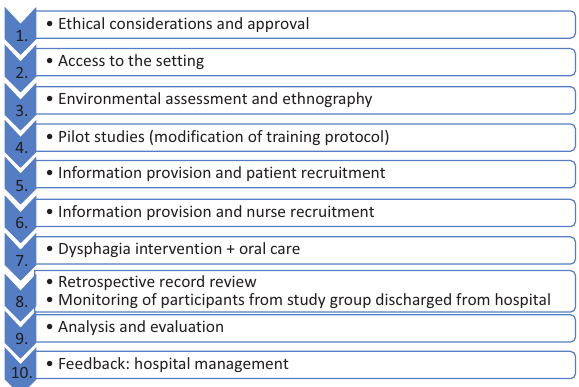
FIGURE 3: Research and data collection